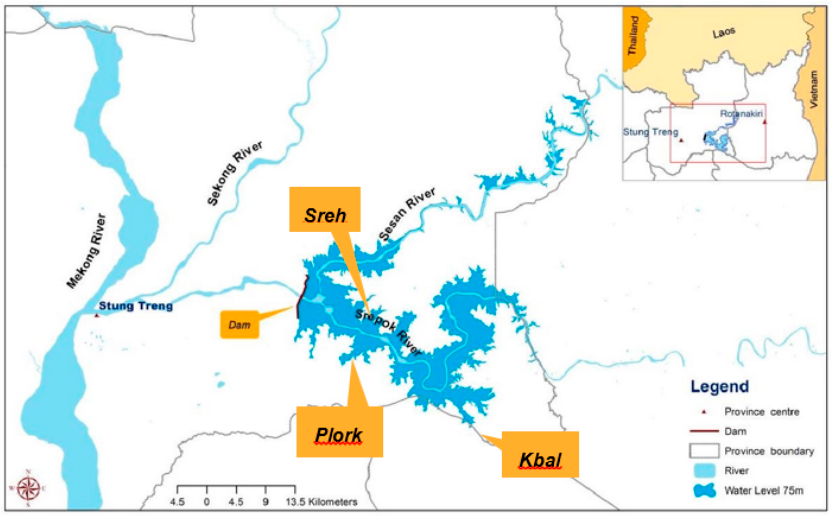
Figure 1. Map and location where fieldwork took place. Source: The map was retrieved from CDRI (Cambodia Development Resource Institute), Theavy Chom.